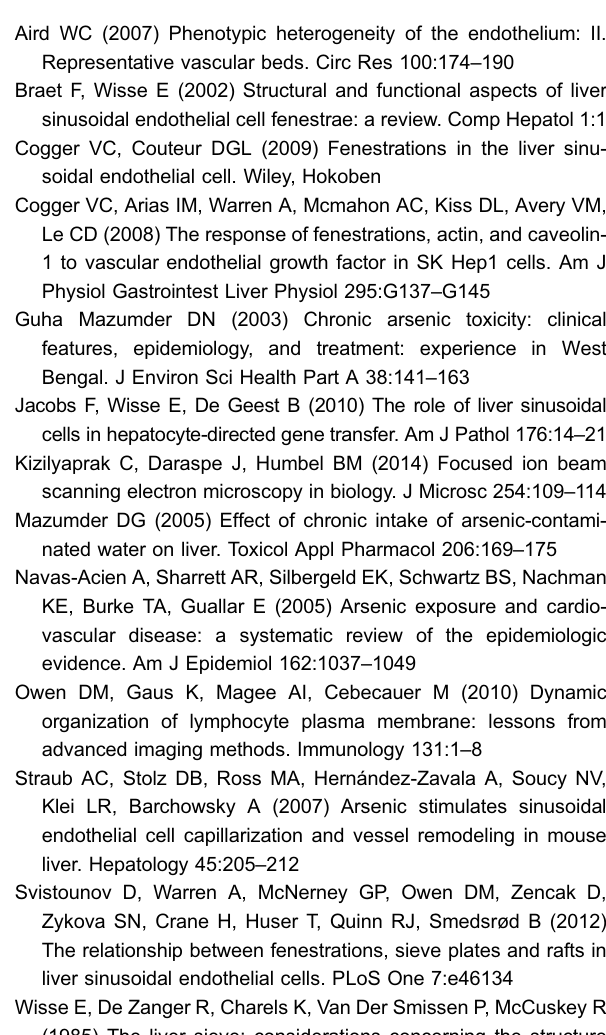
Figure 2. 3D Morphology comparison and quantitative analysis of fenestrations and epithelial cells layers between normal and arsenic treated specimen . (A and B) 3D morphology of fenestrations in normal mice and arsenic treated mice respectively. The endothelial cells are colored in green and the hepatocyte microvilli are colored in cyan. (C) The histogram statistics of the numbers of fenestrations vs. their areas in normal mice (blue) and arsenic treated mice (orange) respectively. The numbers of fenestrations are normalized and shown in their percentages. (D) The statistics of the fenestration numbers larger or smaller than 15,000 nm 2 (up) or 20,000 nm 2 (bottom) for normal specimen (left) and arsenic treated spec- imen (right). (E and F) 3D morphology of sinusoid in normal mice (E) and arsenic treated mice (F) with the epithelia layer colored in green and segmented in right. The scales in X, Y, and Z directions are labeled with the pixel size of 5 nm for XY direction and 15 nm for Z direction. (G) Comparison of the averaged thickness of the epithelial layers for the normal mice and arsenic treated mice. See Supplemental Materials and Methods for the details of epithelial layer thickness measure- ments, sampling, and